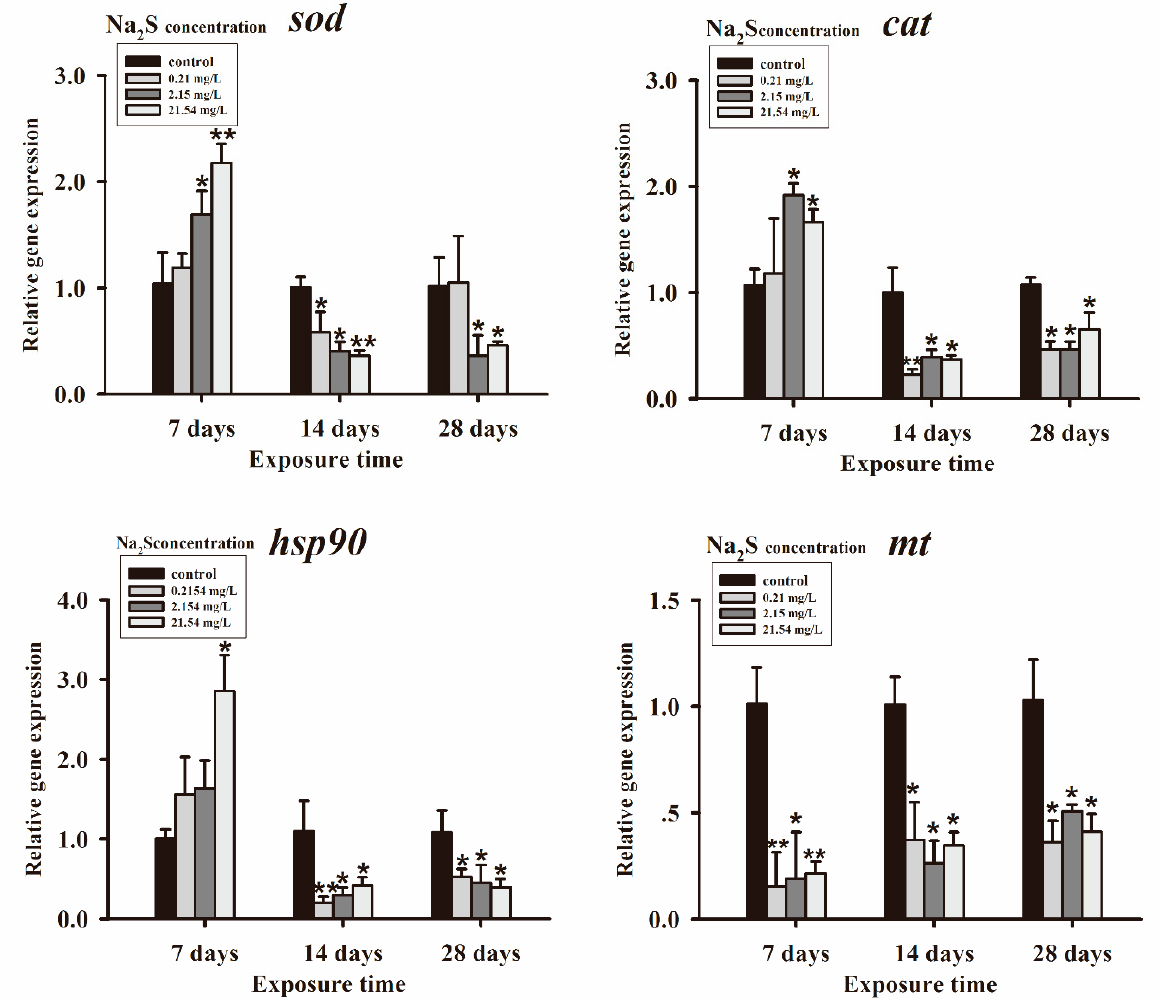
Figure 2. Quantitative RT-PCR analysis of the expression levels of sod , cat , hsp90 , and mt in the liver of rice field eel after exposure to 0, 0.2154, 2.154, and 21.54 mg/L Na 2 S for 7, 14, and 28 days. The results are shown as the mean ± SD of six replicates. * p < 0.05, ** p < 0.01 indicate the statistically significant differences between the exposure and control groups.